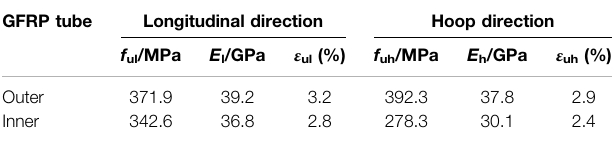
Frontiers in Built Environment |